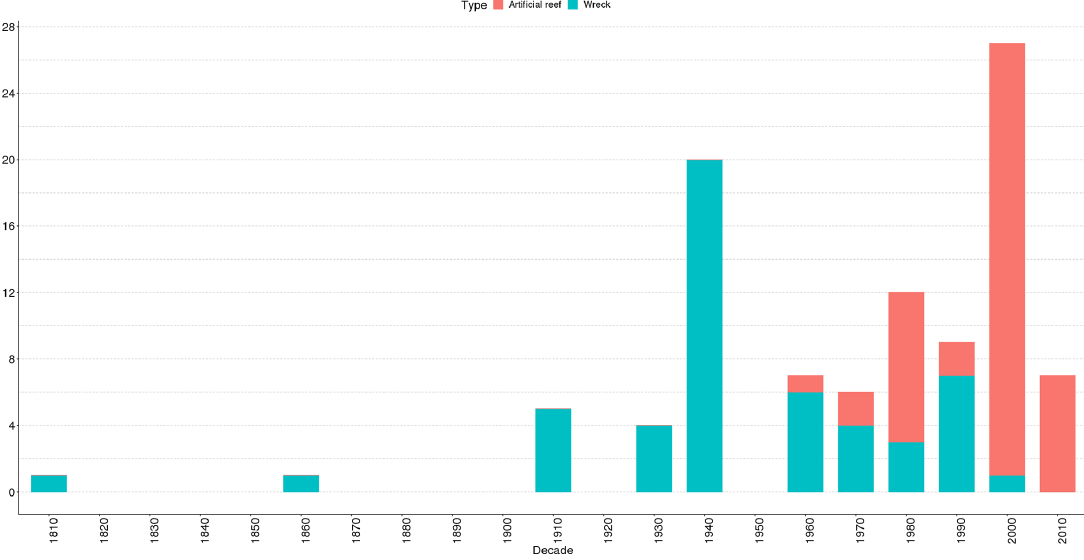
Figure 4. Artificial reefs and wrecks by year of deployment at the decadal